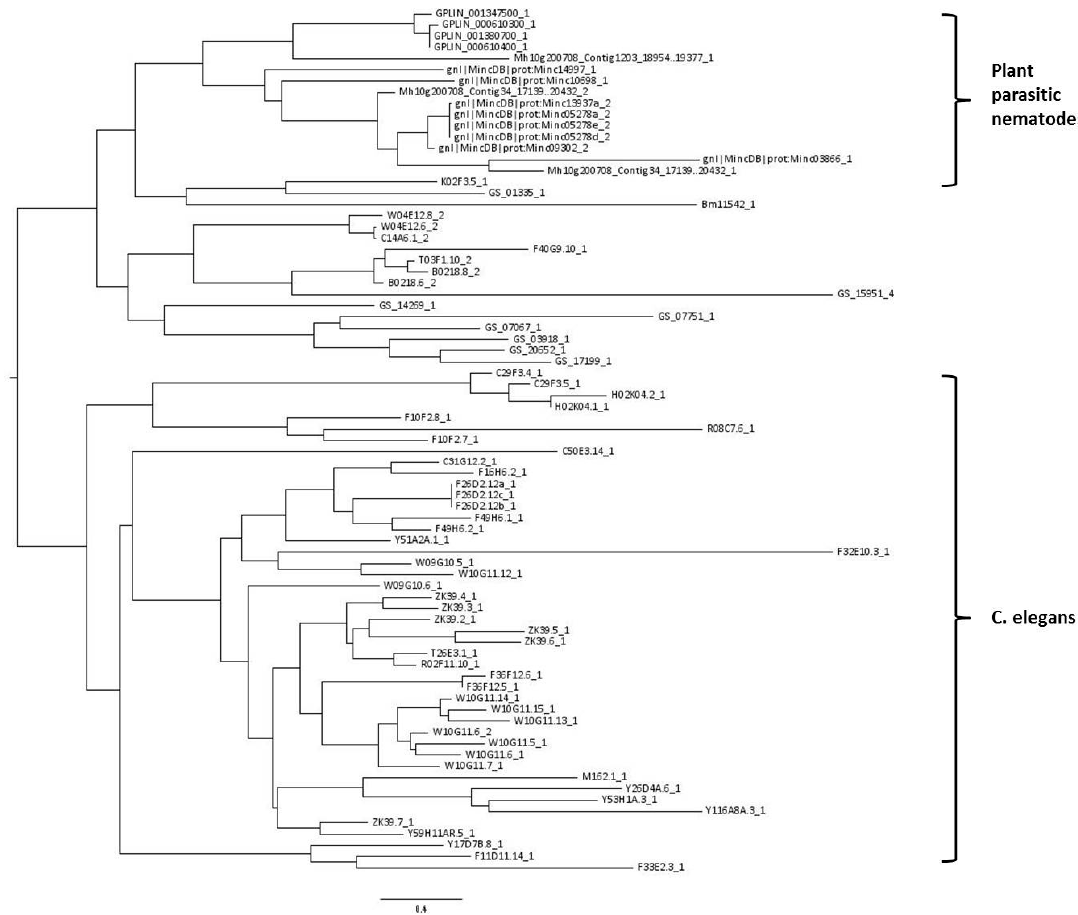
Figure 2. Midpoint rooted phylogenetic tree of 77 nematode C-type lectin-like domains (CTLDs) predicted with the maximum likelihood algorithm. Taxon labels give the full genome accession code of the gene containing the CTLD, followed by a number indicating which CTLD of that particular gene is used in this analysis. Explanation of prefixes: Bm: Brugia malayi , GPLIN: Globodera pallida , Mh10: Meloidogyne hapla , Mincdb: Meloidogyne incognita , GS: Ascaris suum . Taxon labels without any of the previous prefixes originate from Caenorhabditis elegans .